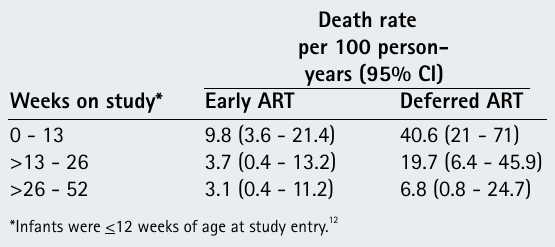
Fig. 1. Deferred ART is associated with a) a higher probability of death or b) first HIV event in the CHER trial. TABLE I. HIGH EARLY MORTALITY RATE IN THE CHER STUDY